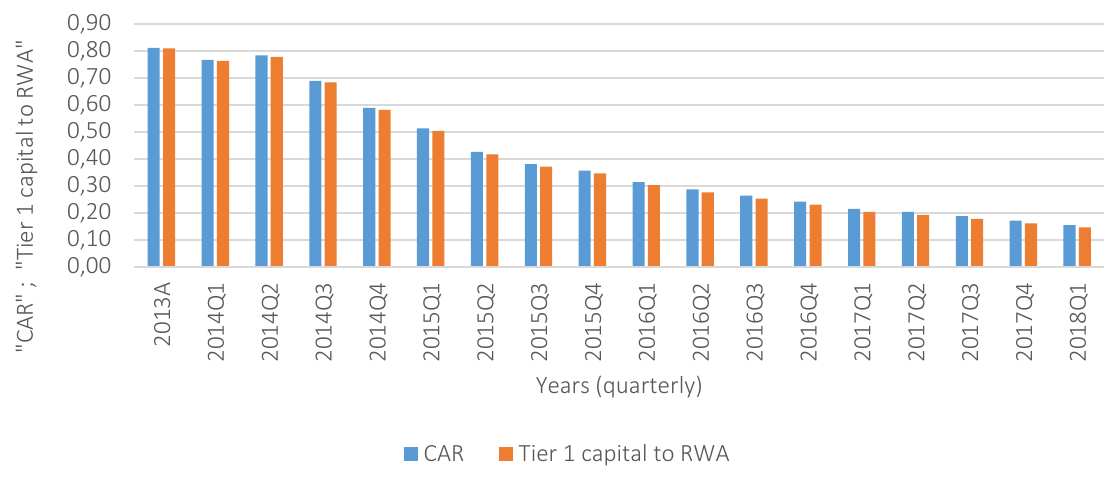
Figure 1. Capital adequacy indicators: CAR (dark) and Tier 1 capital to RWA (grey) for Oman from 2013A to